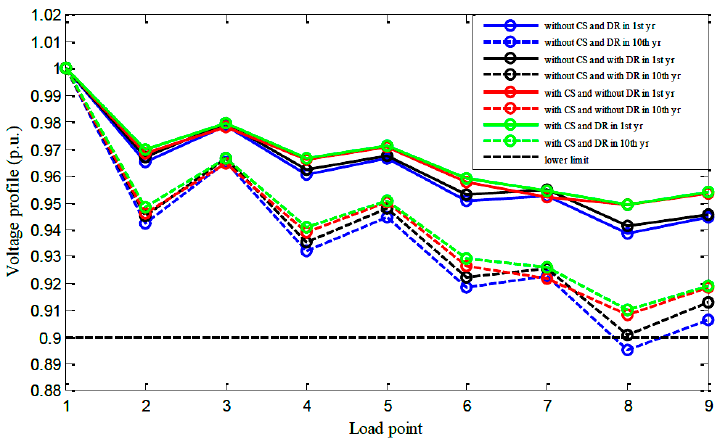
Figure 14. Voltage curve of the studied network in different scenarios and 10 ‐ year load growth application considering three electric vehicle parking lots.